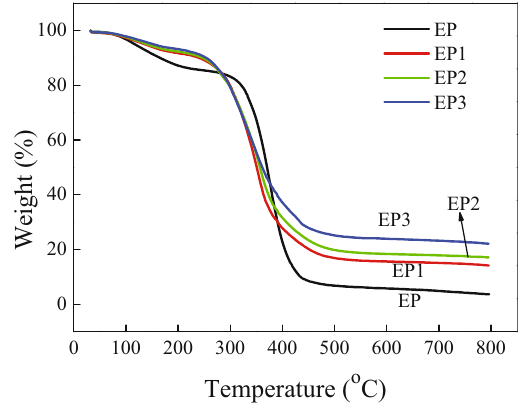
Figure 10: TGA curves of fl ame retardant